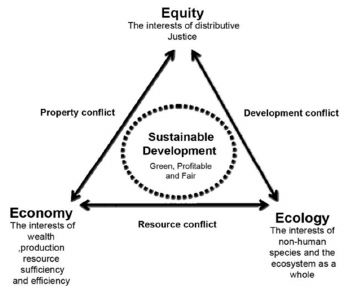
Figure 1. Triangular conflict among key contributors to achieve sustainability. Source: [27].